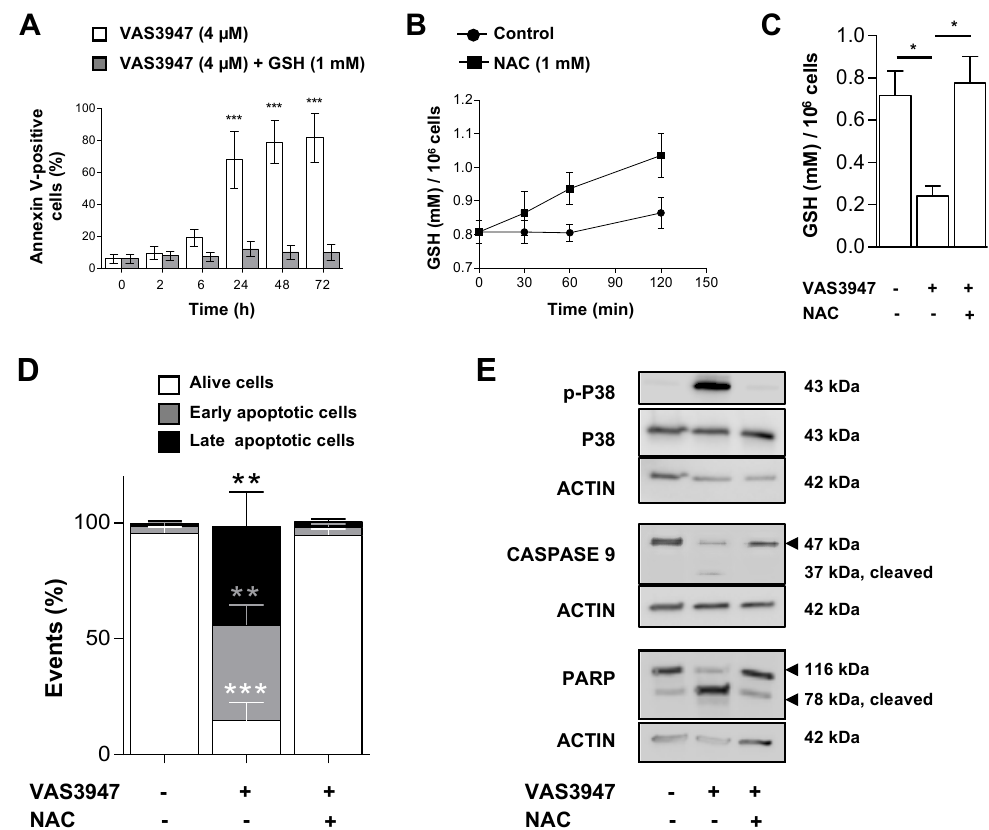
Figure 8. Glutathione (GSH) or N-acetyl cysteine (NAC) supplementation prevents of MV-4-11 cells from VAS3947-induced apoptosis. ( A ) MV-4-11 cells were preincubated with GSH (1 mM) for 2 h, washed, and incubated with VAS3947 prior annexin V-positive cell detection by flow cytometry at the indicated timepoints. Data are shown as mean ± SEM of n = 3 independent experiments. (*** p < 0.001) ( B ) GSH production measured over time in MV-4-11 cells incubated with NAC (1 mM). Data are shown as mean ± SEM of n = 3 independent experiments. ( C ) E ff ect of VAS3947 (4 µ M) on intracellular GSH level in the presence or absence of a 2 hour-NAC preincubation in MV-4-11 cells. Data are shown as mean ± SEM of n = 3 independent experiments. Student’s t -test was performed to compare various conditions to their corresponding control counterparts (* p < 0.05). ( D ) E ff ect of NAC (1 mM) supplementation on VAS3947 (4 µ M)-induced apoptosis in MV-4-11 cells. Student’s t -test was performed for each condition, comparing them to their corresponding control counterparts (** p < 0.01; *** p < 0.001). ( E ) Western blot analysis of apoptotic protein expressions in MV-4-11 cells after treatment as depicted in Figure